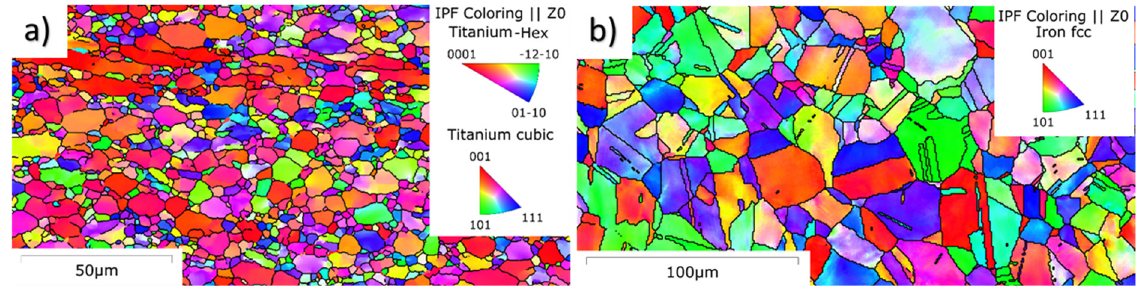
Figure 1. EBSD analysis of transversal cuts of samples of ( a ) Ti6Al4V and ( b ) 316L.